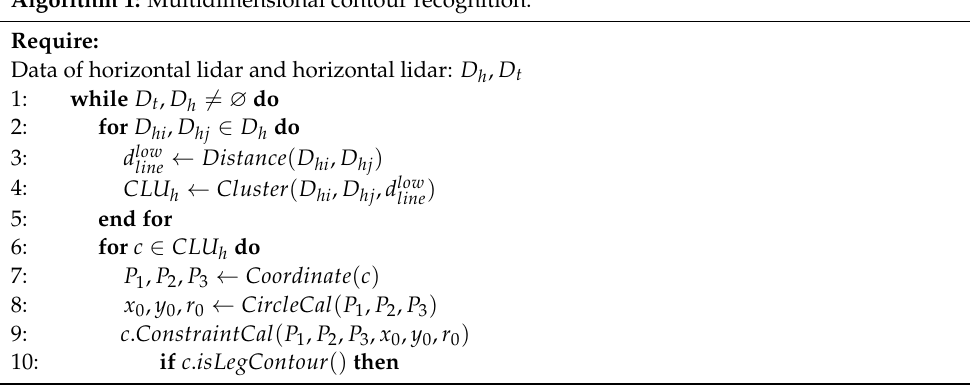
Algorithm 1: Multidimensional contour